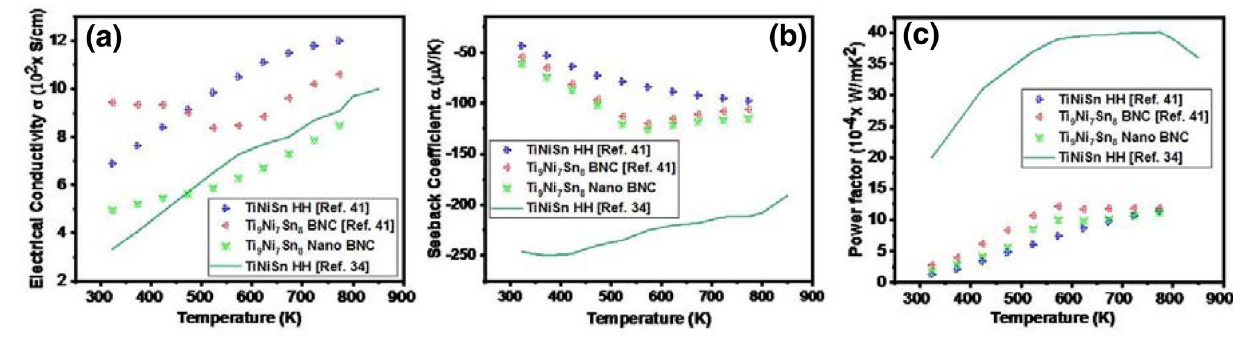
Fig. 2 Temperature dependence of a the electrical conductivity, σ (T); b the Seebeck coefficient, α (T); c the power factor, P.F. ( σα 2 (T)) of